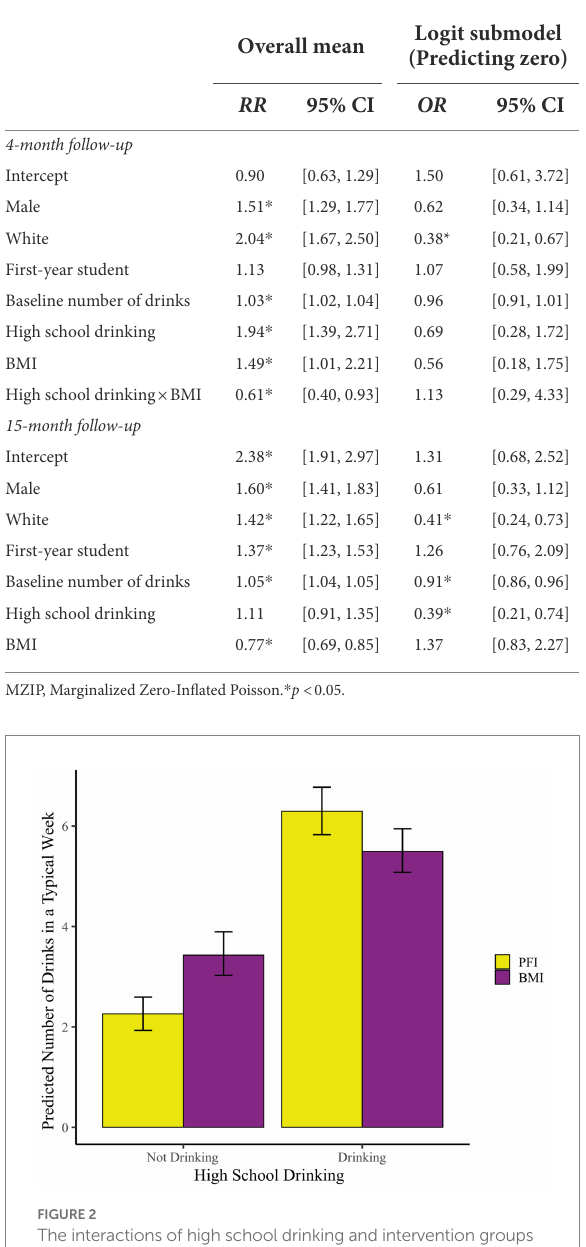
FIGURE 2 The interactions of high school drinking and intervention